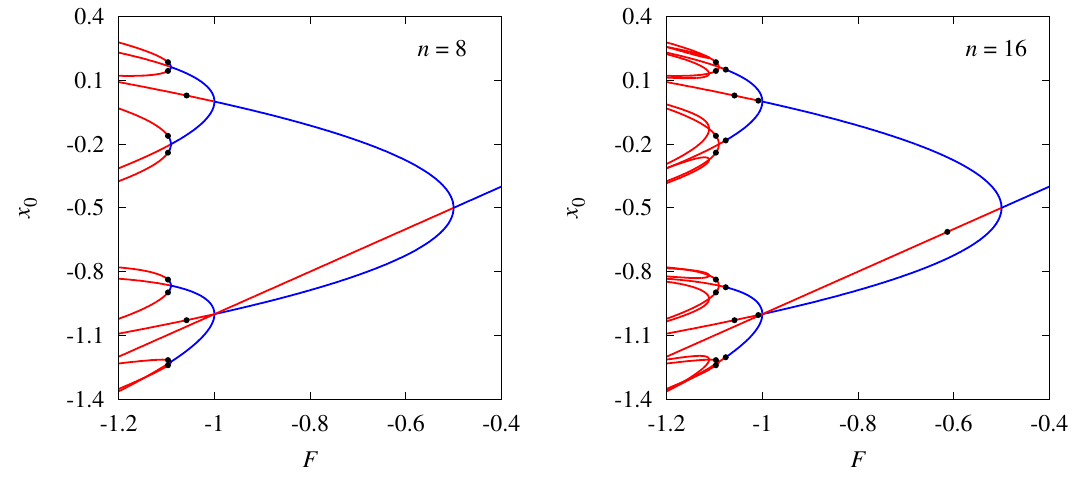
Figure 2. Bifurcation diagrams for the system L − 1, − 1, − 2 ( n ) with n = 8 and n = 16. For dimension n = 8 a Hopf bifurcation (marked with a bullet) destabilizes the equilibria after the last pitchfork bifurcation, whereas, for dimension n = 16, the Hopf bifurcation already occurs before the last pitchfork